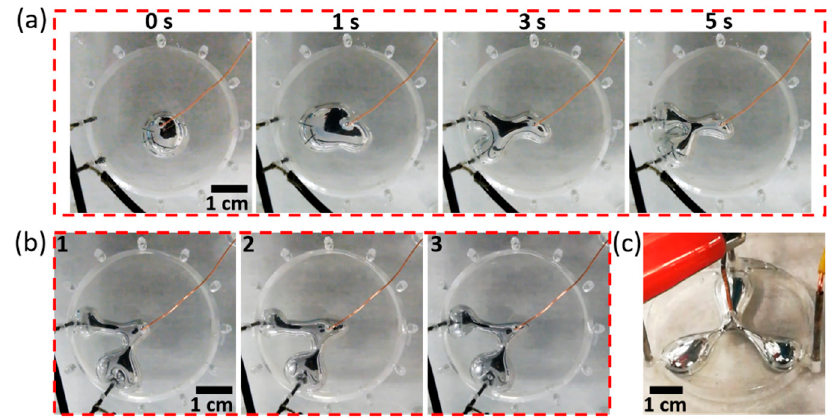
Figure 3. ( a ) Exploring the limit of the system by arranging two cathodes to a configuration of 30°. A series of snapshot images captured at 0, 1, 3 and 5 s after activating the system are shown. ( b ) Exploring the repeatability of the system by recording the morphology variations of the EGaIn droplet at 8 s after activating the system in three separate experiments. ( c ) Morphological control of the EGaIn droplet using three cathodes to yield a fan-shaped pattern with three protrusions.